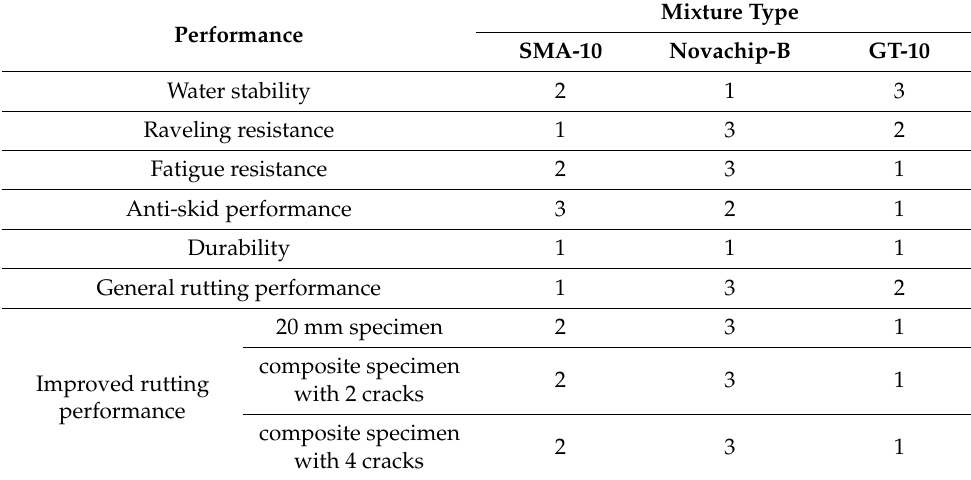
Table 10. Results of UTWC comprehensive